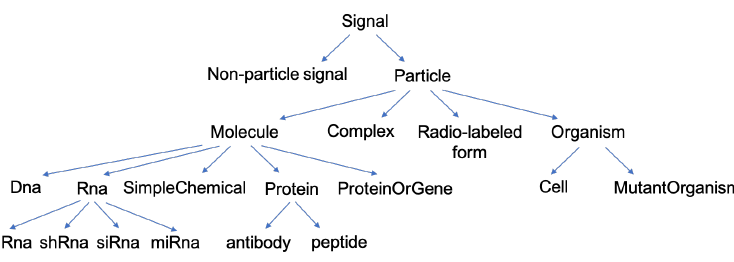
Figure 1. Ontology of the different types of components in a signaling network.